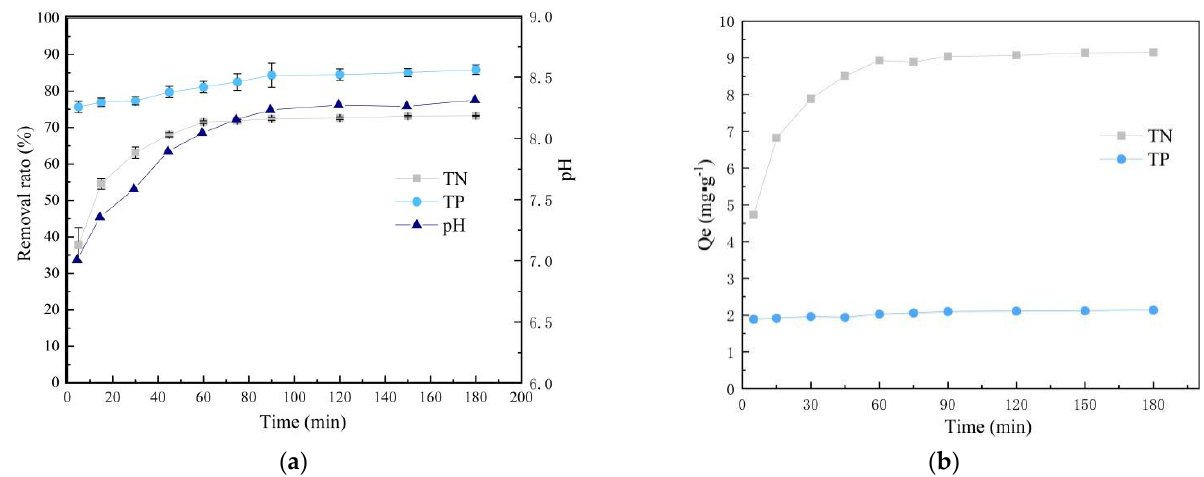
Figure 6. Effect of adsorption time on ammonium and phosphorus removal. ( a ) Change graph of removal rate with increasing contact time, ( b ) change graph of unit adsorption capacity with increasing contact time (C P0 = 10 mg/L; C N0 = 50 mg/L; pH = 7.0; T = 25 °C; adsorbent dosage = 4 g/L) .